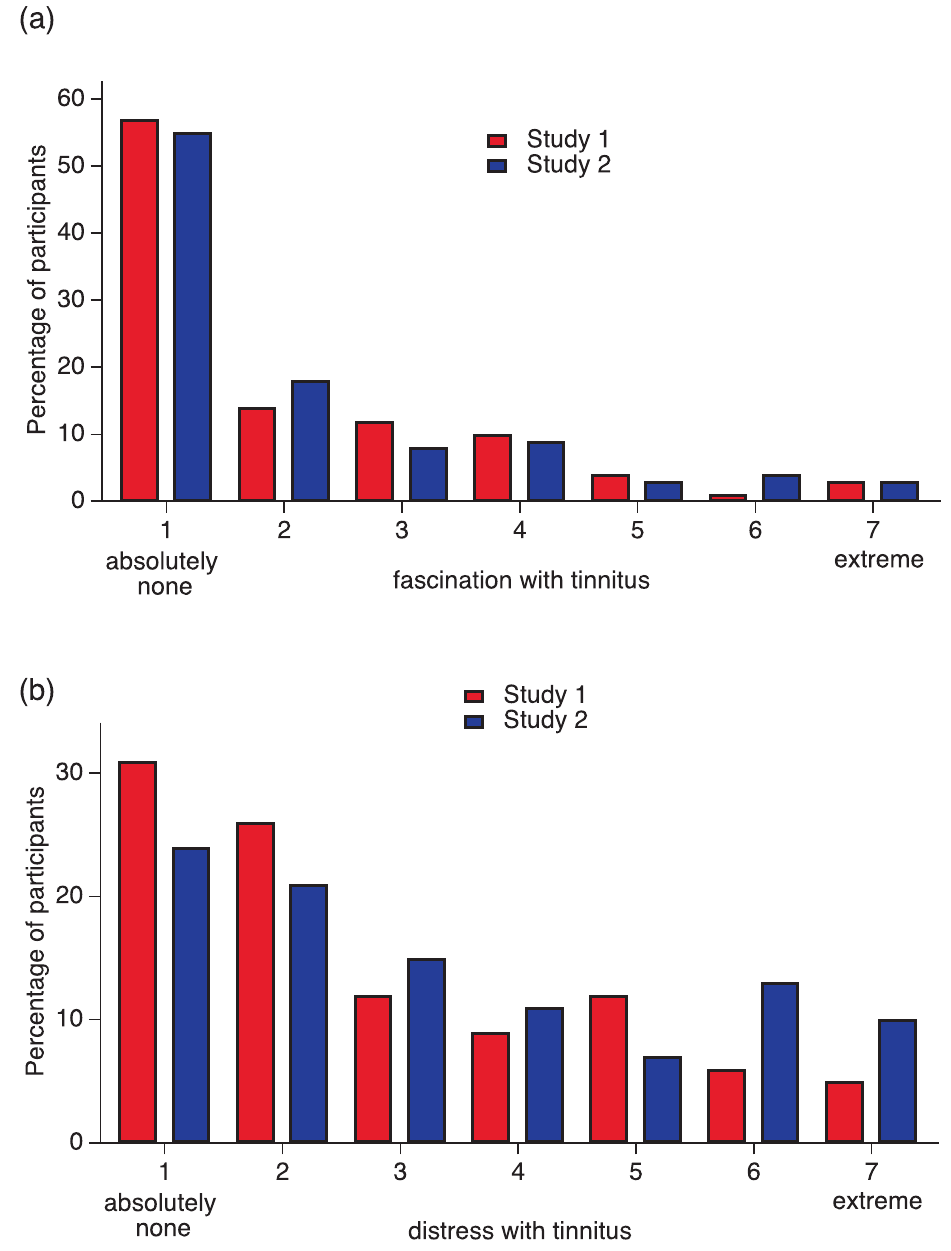
Fig 4. Distress and fascination with tinnitus. (a) Percentage of participants with different degrees of distress with tinnitus. (b) Percentage of participants with different degrees of fascination with tinnitus. Red bars: Data from Study 1. Blue bars: Data from Study